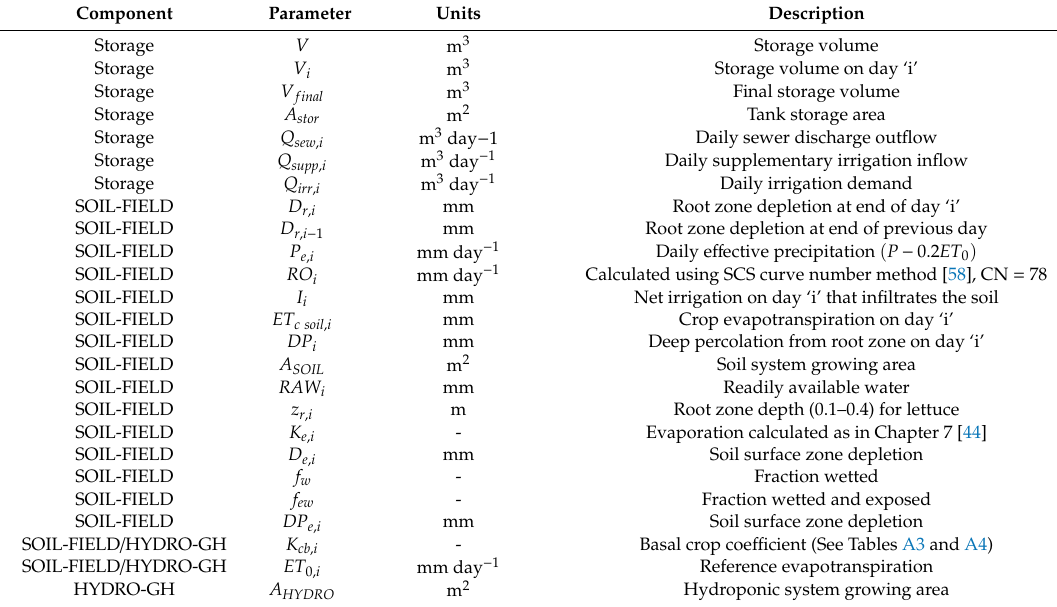
Table A1. Water balance model